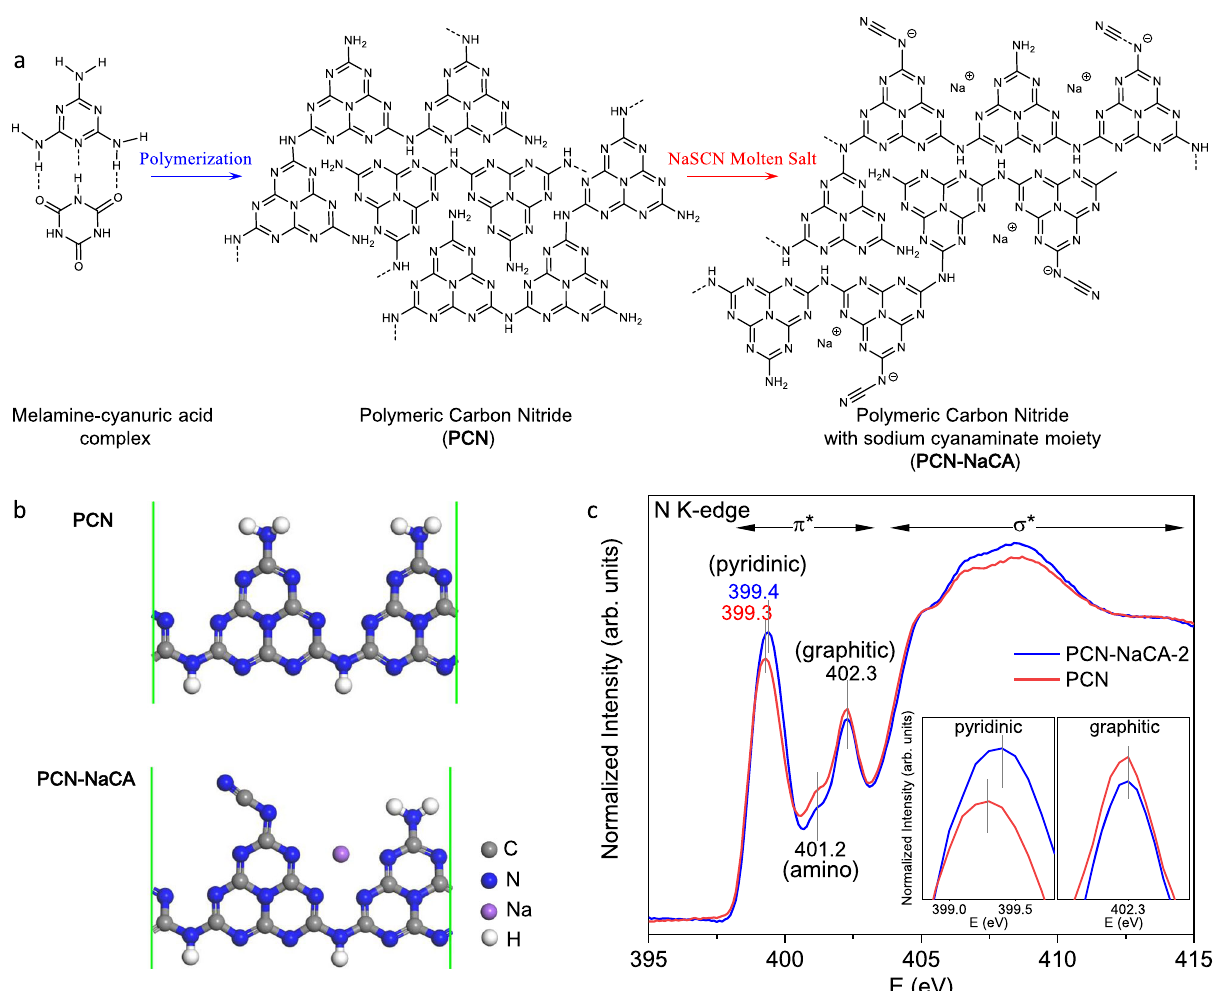
Fig. 2 Synthesis and structure of the photocatalysts. a Synthesis of polymeric carbon nitride (PCN) and polymeric carbon nitride with cyanaminate moiety (PCN-NaCA- n ). b The optimized con fi gurations of PCN and PCN-NaCA by DFT calculation. c N K-edge x-ray absorption near edge structure (XANES) of PCN and PCN-NaCA-2. The insets show enlarged peaks of pyridinic nitrogen and graphitic